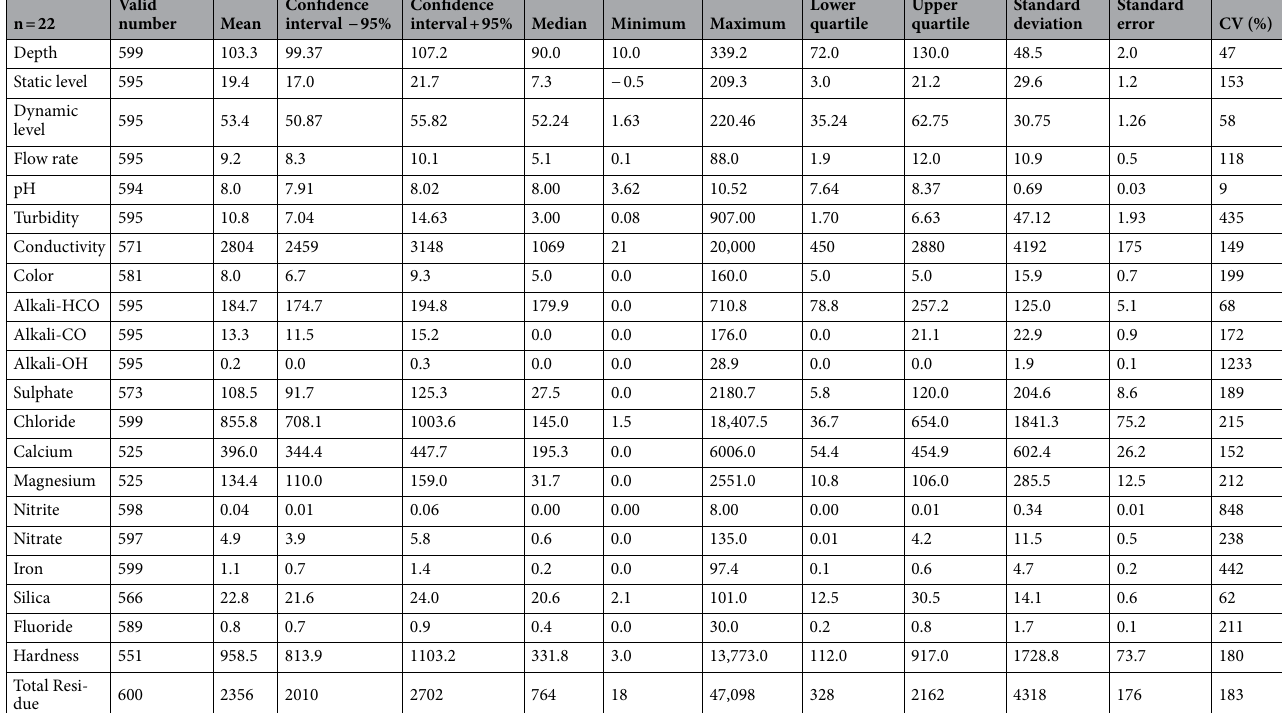
Table 3. Descriptive statistics including the coefficient of variation (CV), with 22 representative variables.